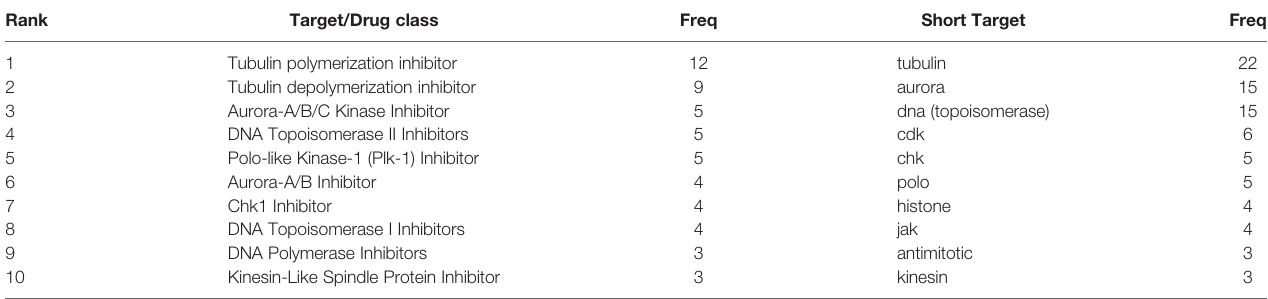
TABLE 1 | Frequency of target